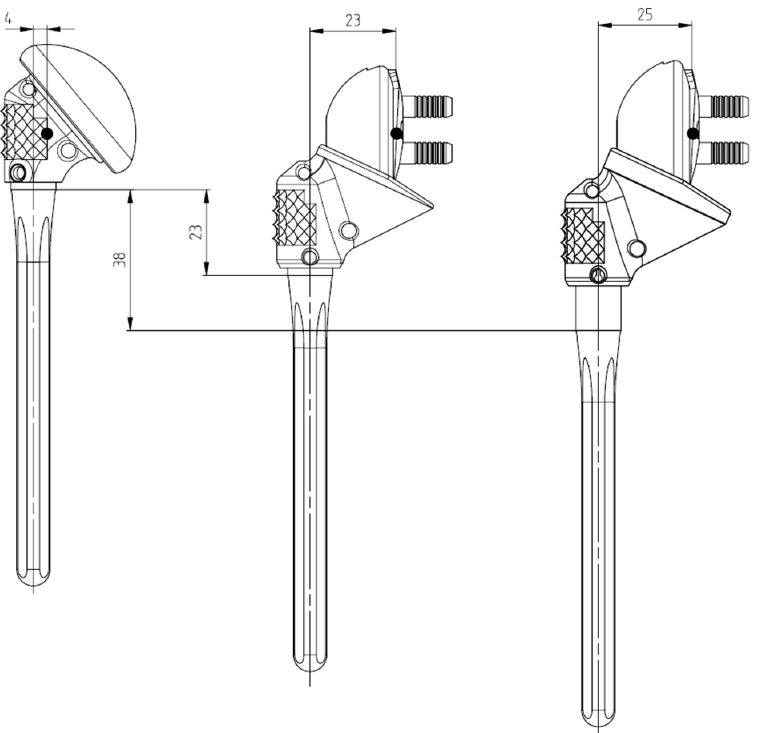
Figure 3. Modular reverse shoulder prosthesis. If both metaphyseal parts are at the same level, conversion leads to 23 mm of distalization and medializes the center of rotation by 19 mm (left). This corresponds to the worst-case scenario if the reverse metaphyseal element was placed most distally during the primary implantation of hemiarthroplasty (middle). The maximum lengthening of the conversion is 38 mm by choosing a 42 mm glenosphere and an offset of 3 mm (right). The length of the anatomic and the reverse prosthesis can be adjusted by 10 mm to reduce distalization. The center of rotation is medialized between 19 mm and 21 mm.